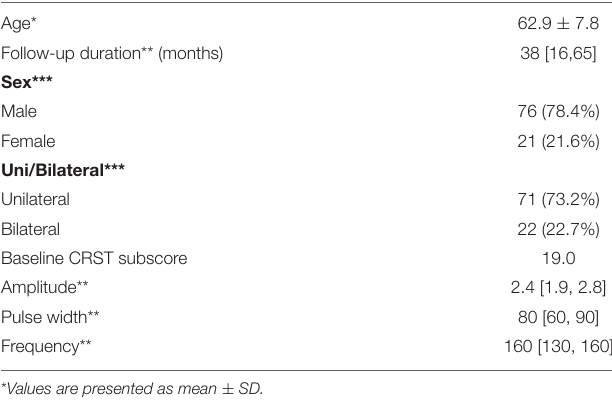
TABLE 1 | Patient demographics and stimulation parameters.